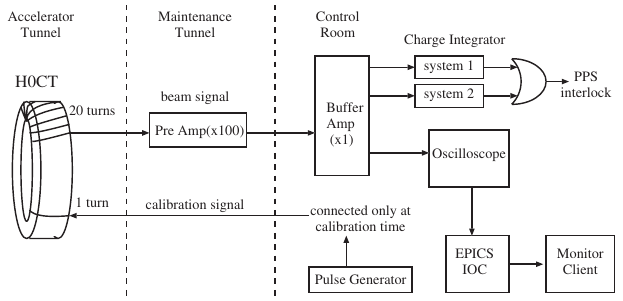
FIG. 2. A sketch of the H0CT and data taking logic. In the present measurement, a two stage amplified signal was fed to an oscilloscope which was online controllable by